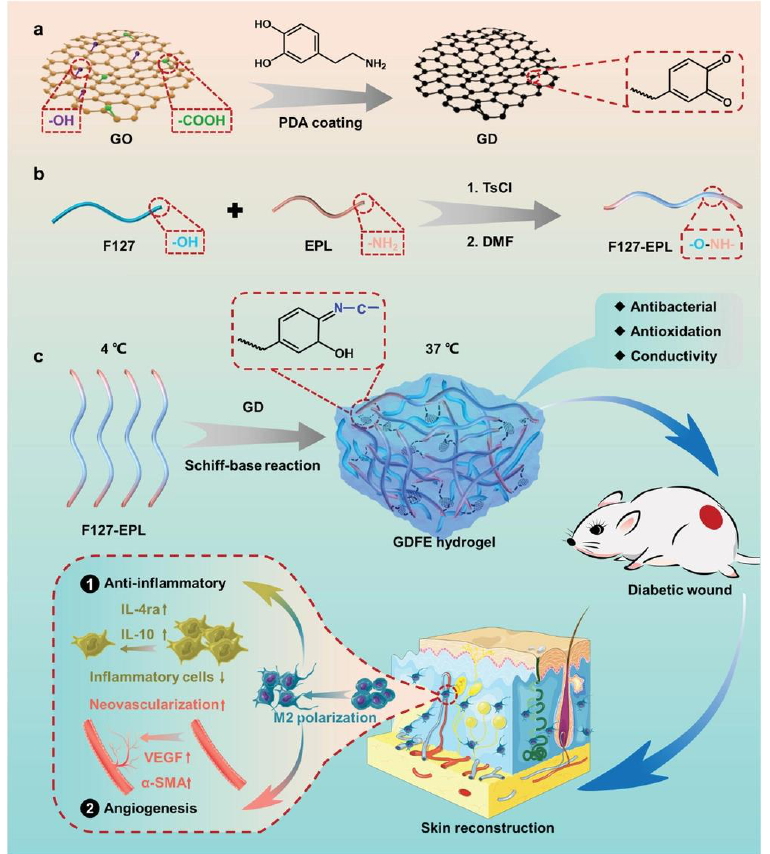
Figure 9. Schematic illustration of the synthesis of GDFE hydrogel with multifunctional properties for potential application in diabetic wound healing and skin reconstruction. ( a ) Schematic diagram of syn- thesis of GD. ( b ) Schematic diagram of synthesis of FE hydrogel. ( c ) The preparation, multifunctional properties and application of GDFE hydrogel. Reprinted with permission from ref.